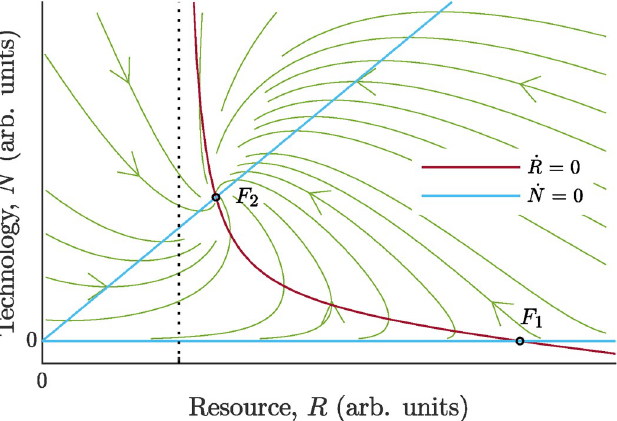
Fig 5. Phase portrait of the system (19). The unpopulated steady state F 1 , given by (23a), is a saddle point, while the positive equilibrium, F 2 , given by (23b), is a stable node. The steady-states lie on the intersections of the nullclines. The vertical nullcline _ R ¼ 0 is the hyperbola N = R ( r − dR )/(( dK + γ q ) R − Kr ) with the asymptote R = Kr /( dK + γ q ) (shown by the dotted line). The horizontal nullcline _ N ¼ 0 consists of two lines, N = 0 and N = R ( γ − D )/( DK